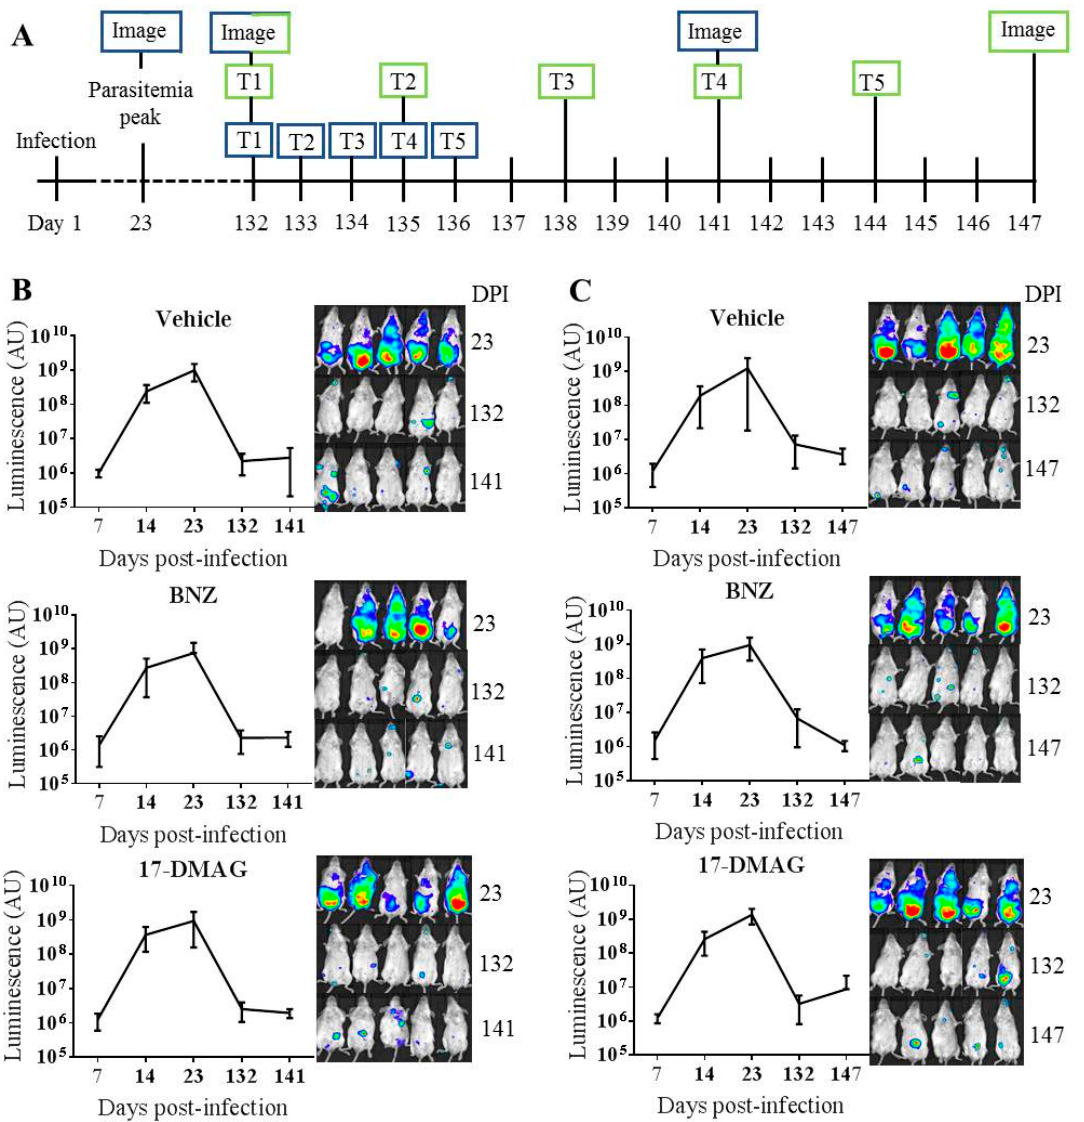
Figure 6. In vivo model of chronic T. cruzi infection. ( A ) Experimental timeline of events. Blue squares refer to experimental groups treated daily for five days whereas green squares to groups treated five times over 15 days. ( B ) Parasitemia evolution represented by graphs and images of animals treated daily for five days. ( C ) Parasitemia evolution represented by graphs and images of animals treated five times over 15 days. The luminescence reactivity shown longitudinally in panels B and C are mean and SD values of all the mice within each corresponding